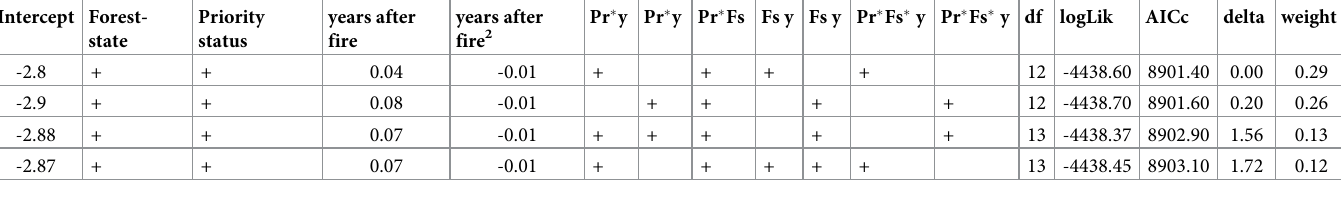
y = years after fire, Fs = forest state. For an overview of the best model for priority analysis with territories after model averaging, see S7